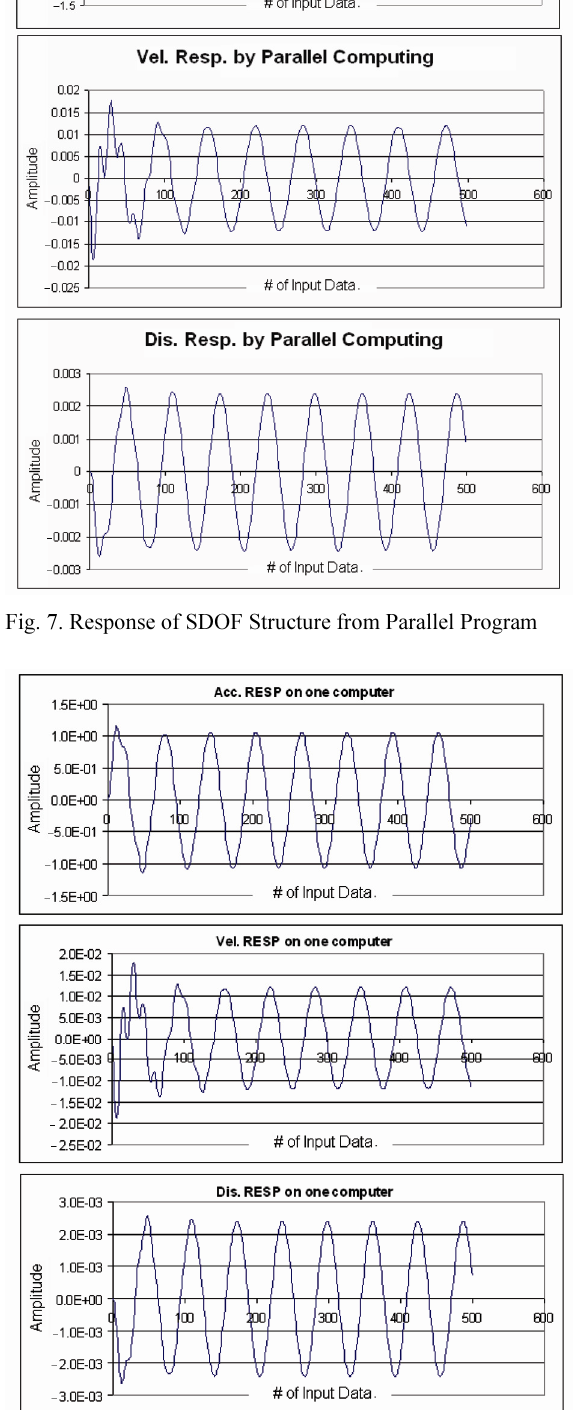
Fig. 8. Response of SDOF Structure from Sequential